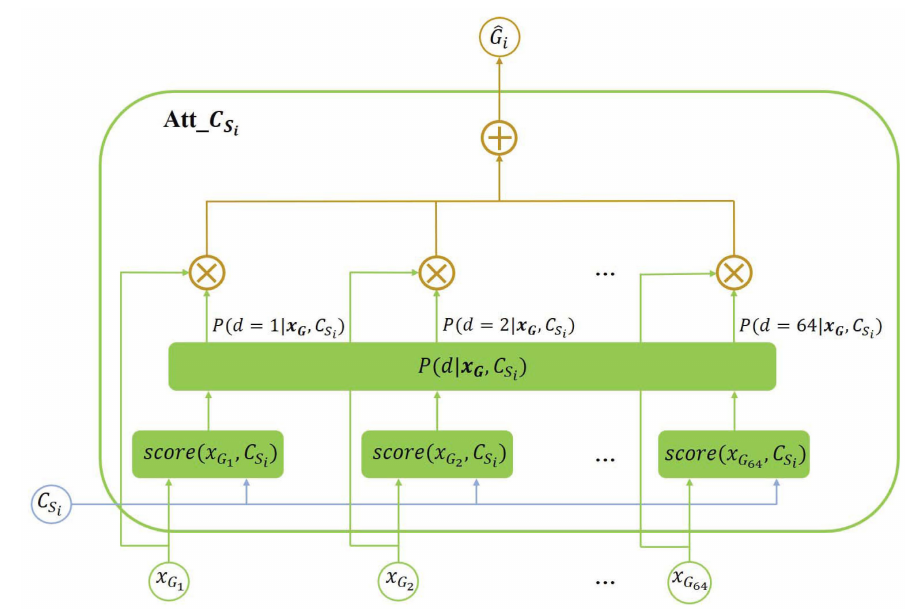
Figure 4. The designed smile/non-smile context attention